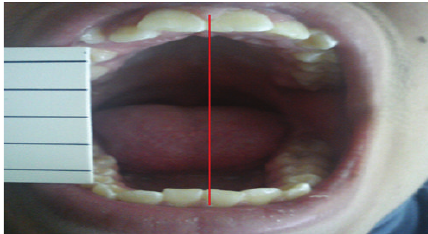
Figure 10: Trismus measurement using the algorithm developed. The maximum mouth opening distance is 7.3627 cm.